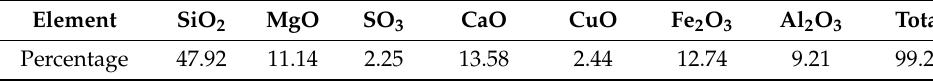
Table 4. Chemical composition of copper slag (wt/%).